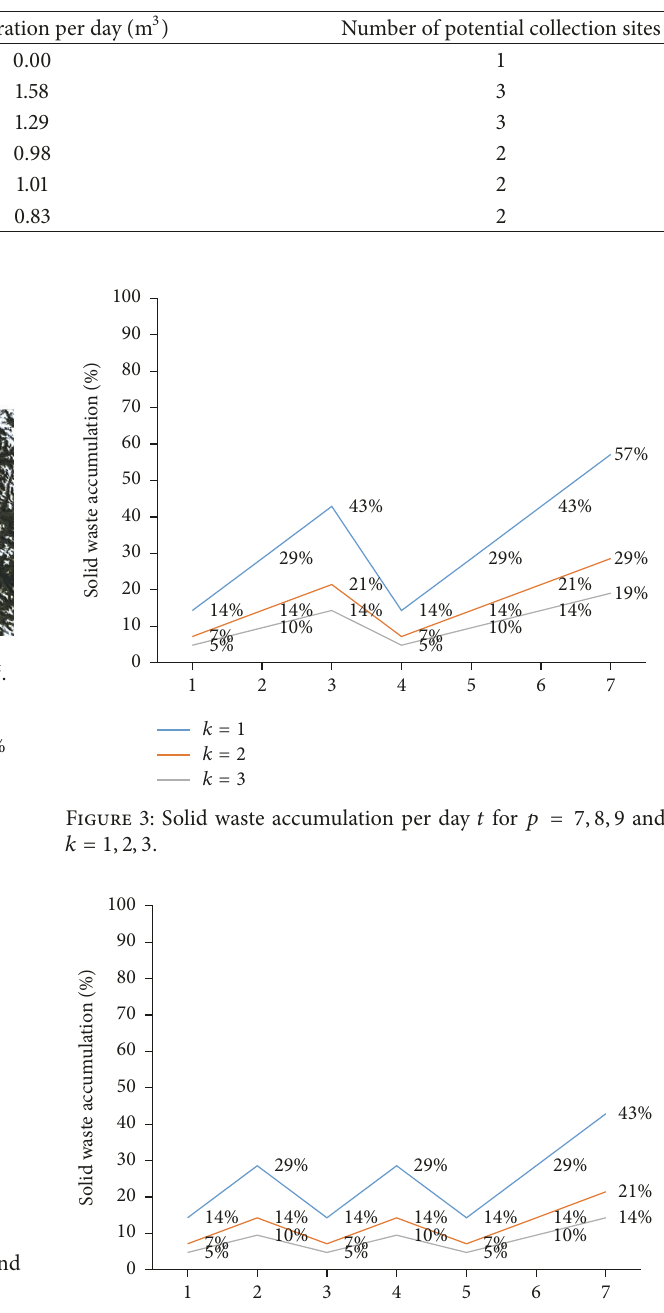
Table 2: Name of the islands, waste generation per day in 2015, and potential collection sites for each island [13].